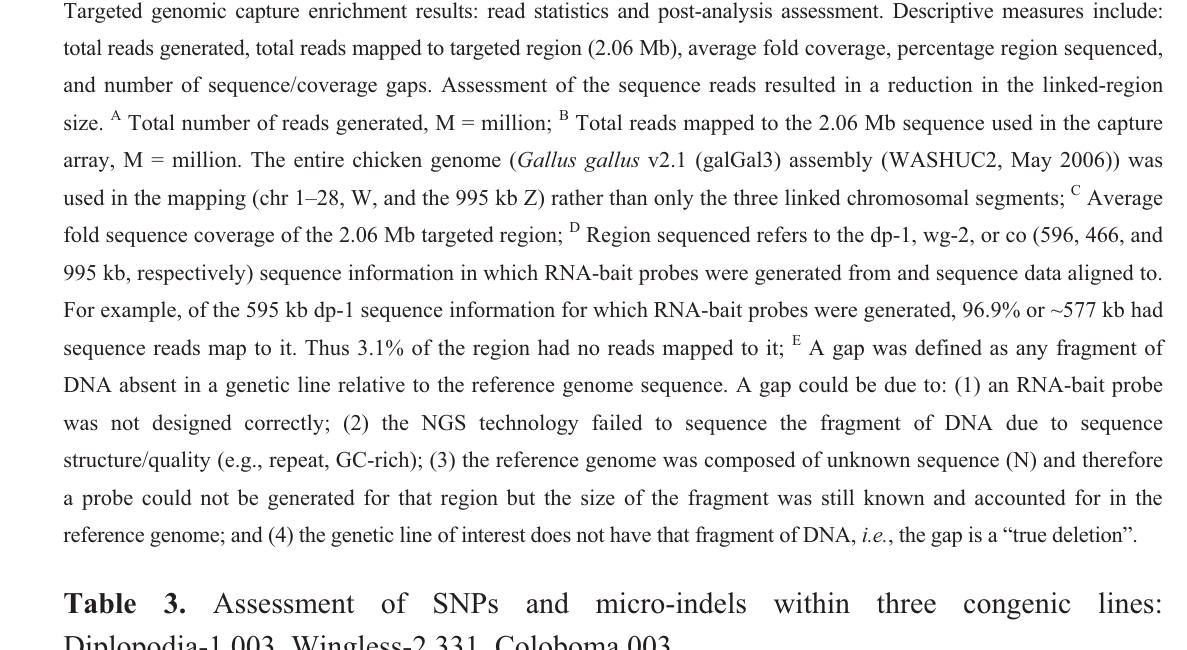
Table 3. Assessment of SNPs and micro-indels within three congenic